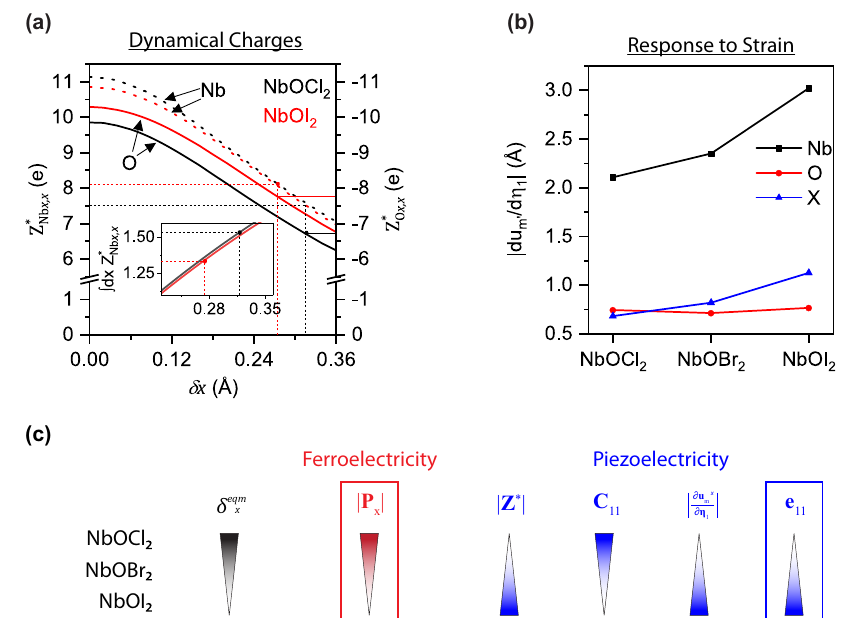
Fig. 6 Understanding the origin of piezoelectric and ferroelectric effects in the NbOX 2 family. a Dynamical charges for Nb and O, Z (cid:2) Nbx ; x and Z (cid:2) Ox ; x . as a function of δ x , the difference between the longer and shorter Nb-O bonds. The inset shows the integral of Z (cid:2) Nbx ; x with respect to the x -displacement away from the high-symmetry site. In both the main fi gure and the inset, dashed lines indicate the values in the equilibrium structures. b ∂ u mx ∂ η structures of NbOX 2 , indicating the rate of change of x- displacement of each atom (Nb, O, or X) with strain in the x- direction. NbOI 2 has the largest lattice response to strain, due to the smaller stiffness tensor elements and weaker Nb-O bonds. c Schematic illustrating the origins of the trends in ferroelectricity and piezoelectricity in NbOX 2